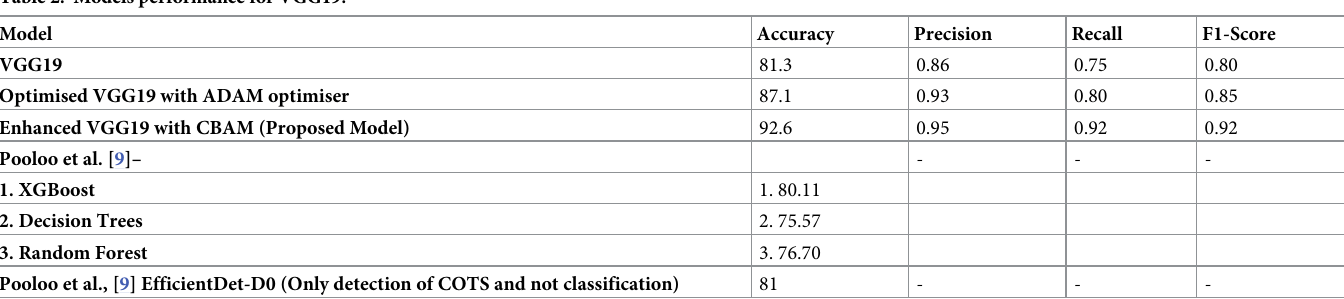
Table 2. Models performance for VGG19.